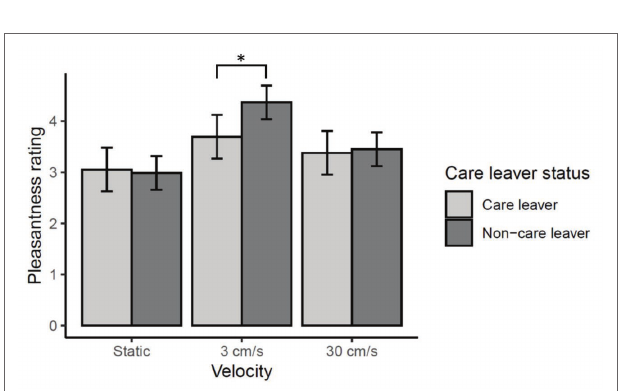
FIGURE 5 | Effect of care leaver status on vicarious touch pleasantness ratings. Mean pleasantness ratings ±95% confidence intervals are shown. There was a significant care leaver status by velocity interaction ( p = 0.0001), which reflects the fact care leavers rated touch at 3 cm/s significantly lower than non-care leavers (* p < 0.01). There was no significant difference between the two groups’ ratings at either of the other velocities ( ps >